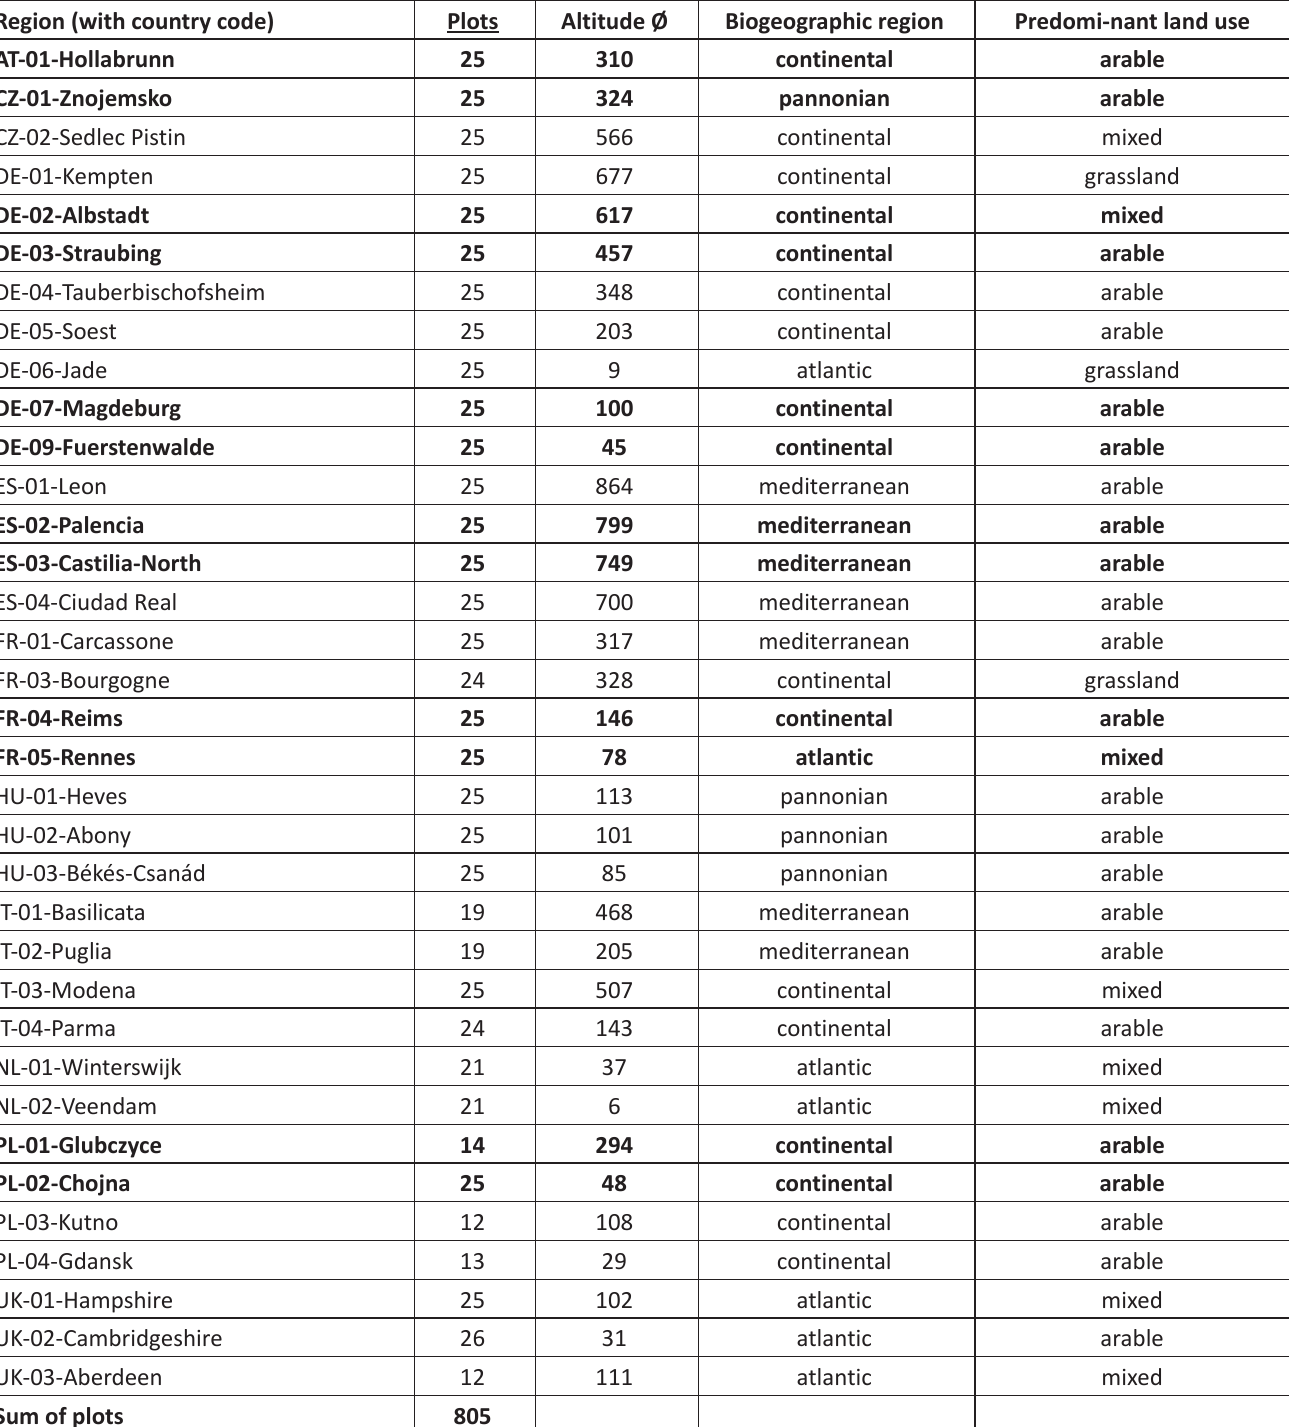
Table S3. Overview of regions surveyed in study (regions re-assessed in 2016 are highlighted in bold). The number of plots in each region is mostly 25, however not in all regions the number of 25 plots could be